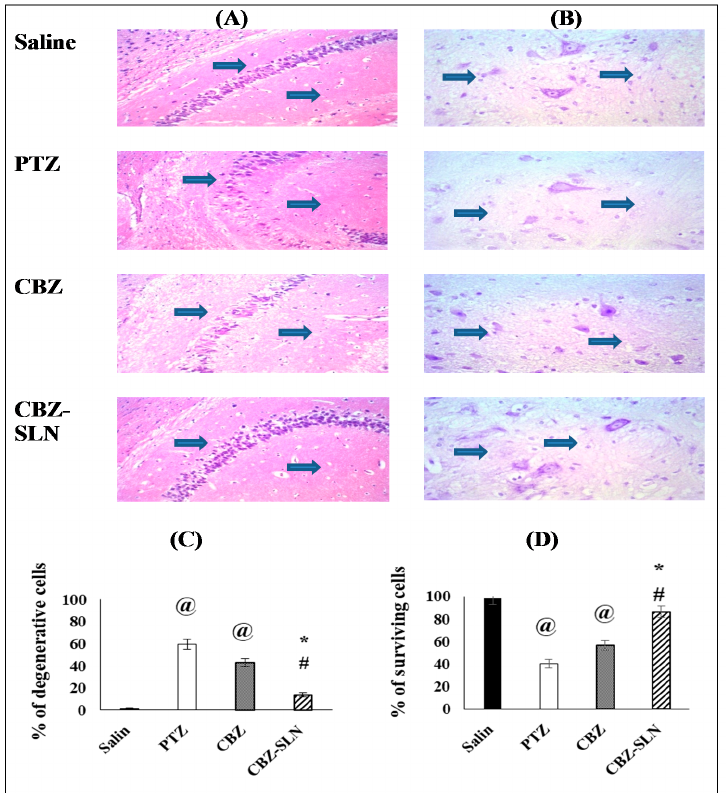
Figure 8. The e ff ect of all pharmacological treatments in the photographic pictures of the hippocampus sections. ( A ) Histopathological pictures stained with hematoxylin plus eosin, ( B ) photographic pictures of hippocampus sections stained with Cresyl violet, ( C ) the percentage of degenerative cells in the hippocampal area of the di ff erent groups, and ( D ) the percentage of surviving cells in the hippocampal area of the di ff erent groups. Data are presented as mean ± SEM and were analyzed using a one-way ANOVA followed by Bonferroni’s post-hoc test at p < 0.05. @ compared to the saline group, * Compared to the PTZ group, # compared to the CBZ